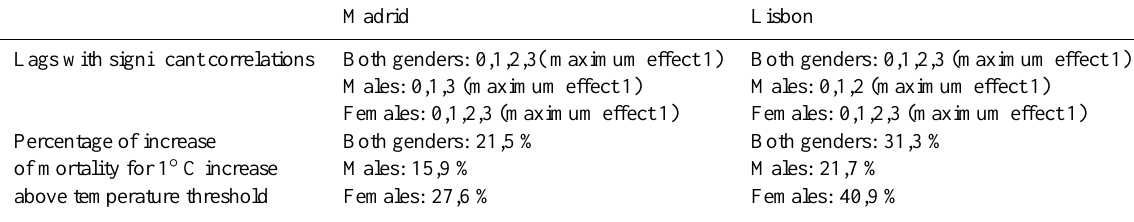
Table 2. Temperature impact for both